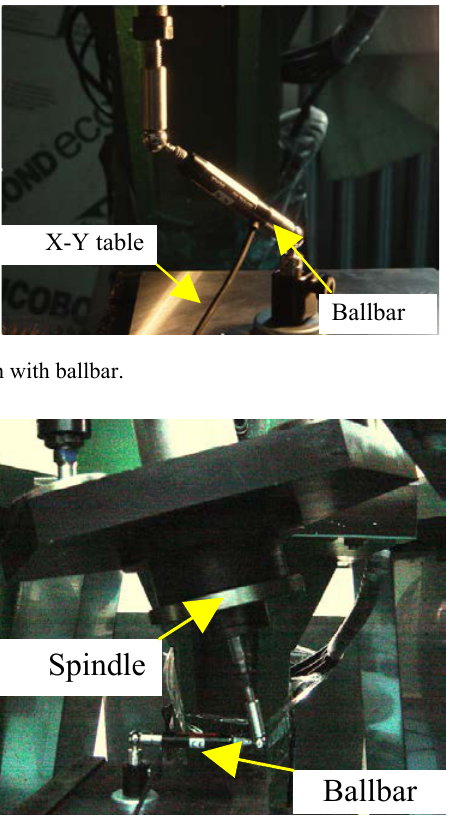
Fig. 4. Spindle deflection roundness